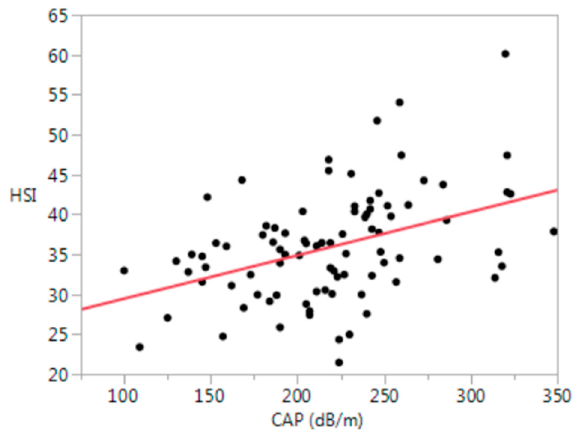
Figure 2. Relationship between the HSI and CAP (r = 0.41, p < 0.0001).